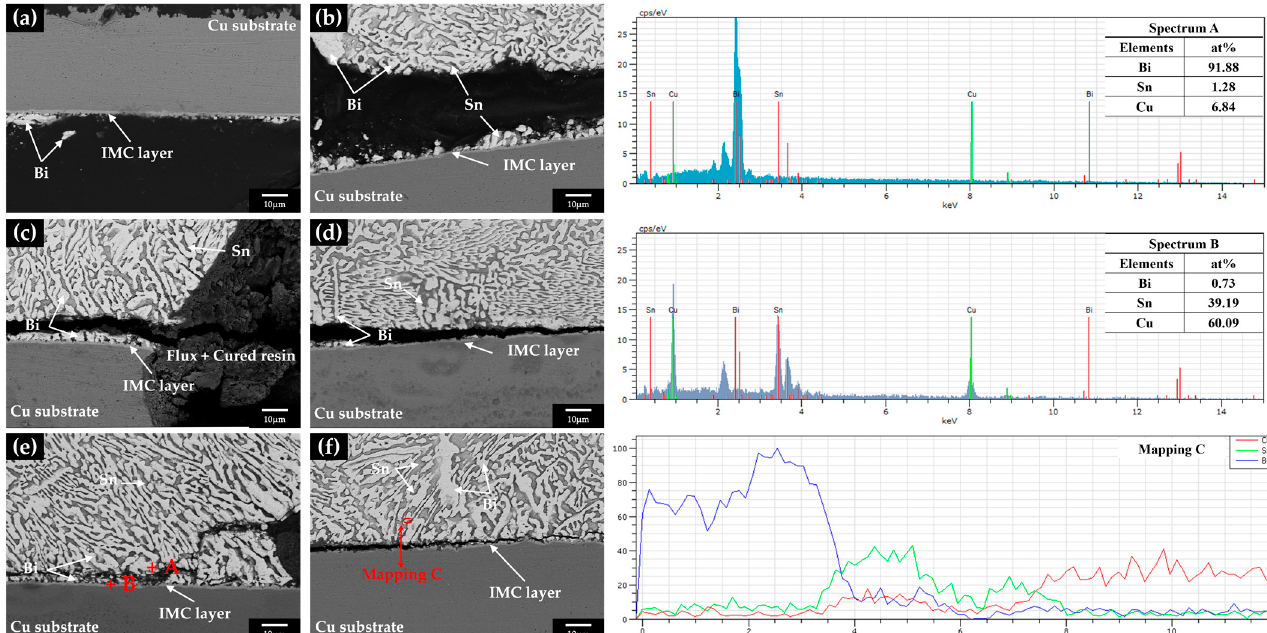
Figure 10. The SEM and EDS cross-section microstructure of solder joint crack paths: ( a , b ) Sn–Bi/Sn– Bi, ( c , d ) Sn–Bi/TSEP Sn–Bi-3, ( e ) Sn–Bi/TSEP Sn–Bi-5, ( f ) Sn–Bi/TSEP Sn–Bi-7.